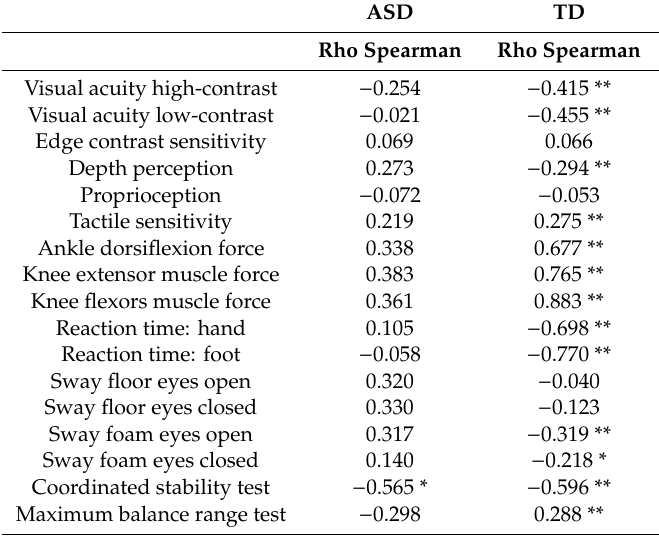
Table 2. Correlations between individual test performance and